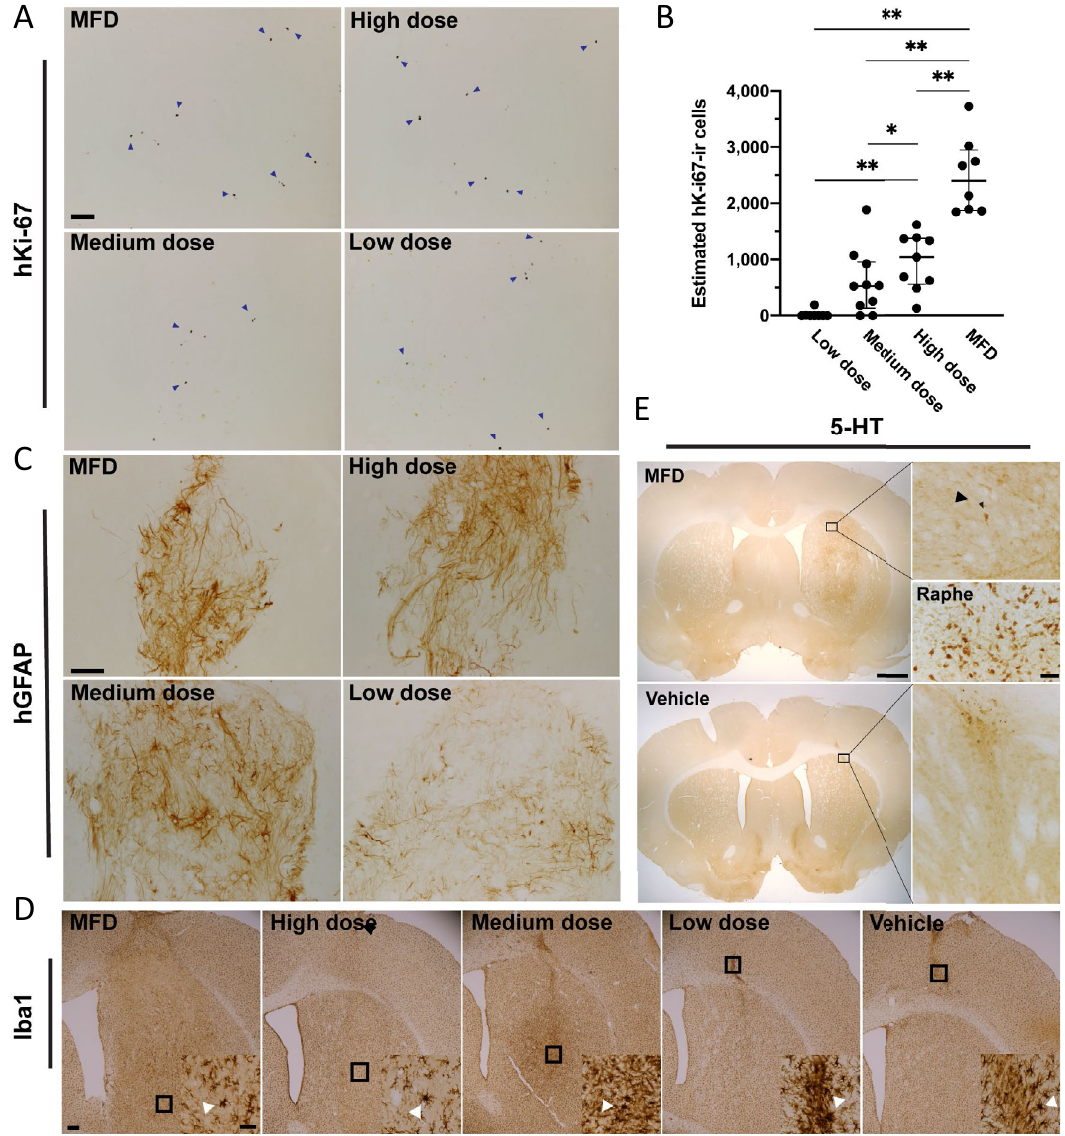
Fig. 8 Non-dopaminergic cell types observed in grafts. Representative A micrographs of graft sections stained for hKi-67 and B stereological estimates for each group. C Representative images of graft sections stained for hGFAP (glia), D , Iba1 (microglia), and E 5-HT (serotonergic neurons). Scale bar A = 100 μ M; C = 200 μ M; D = 500 μ M; E = 1 mm ( E , inset) = 25 μ M. P < 0.05 for medium vs. low dose; P < 0.005 for all other comparisons by Kruskal – Wallis test with Dwass, Steel, Critchlow-Fligner method. * p < 0.05 ** p <